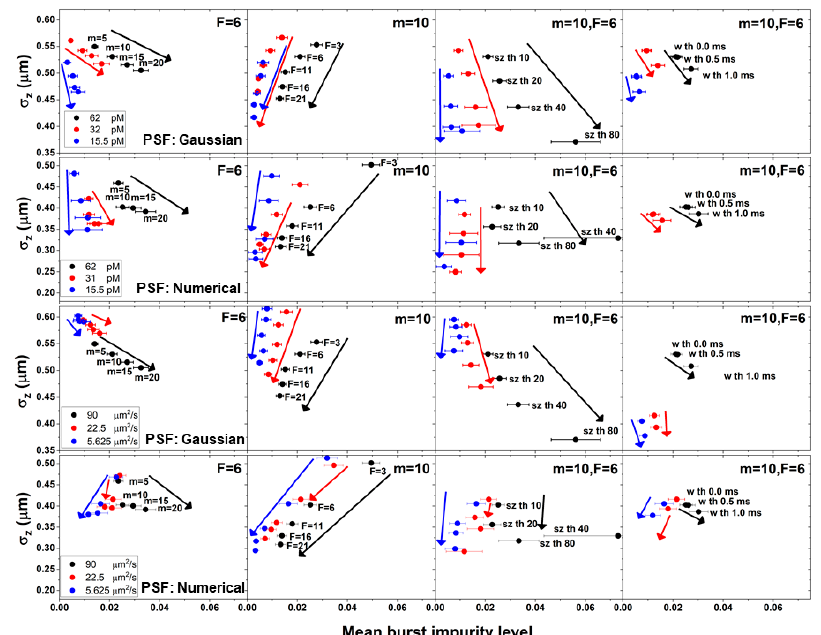
Figure 6. The correlation of burst impurity with molecular position dispersion. Different burst analysis parameter values for different concentrations of molecules. The mean burst impurity levels (error ranges calculated as the standard error) were compared against the molecular position dispersion in the z coordinate (error ranges calculated as the uncertainty of the standard deviation), as a function of different burst analysis parameter values (from left to right: varying m values, varying F values, varying burst size threshold values, and varying burst width threshold values), for different simulation conditions (from top to bottom: Different concentrations at a constant diffusion coefficient value of 90 μ m 2 /s in simulations using the Gaussian PSF model, different concentrations at a constant diffusion coefficient value of 90 μ m 2 /s in simulations using the numerical PSF model, different diffusion coefficients at a constant concentration of 62 pM in simulations using the Gaussian PSF model, and, different diffusion coefficients at a constant concentration of 62 pM in simulations using the numerical PSF model).